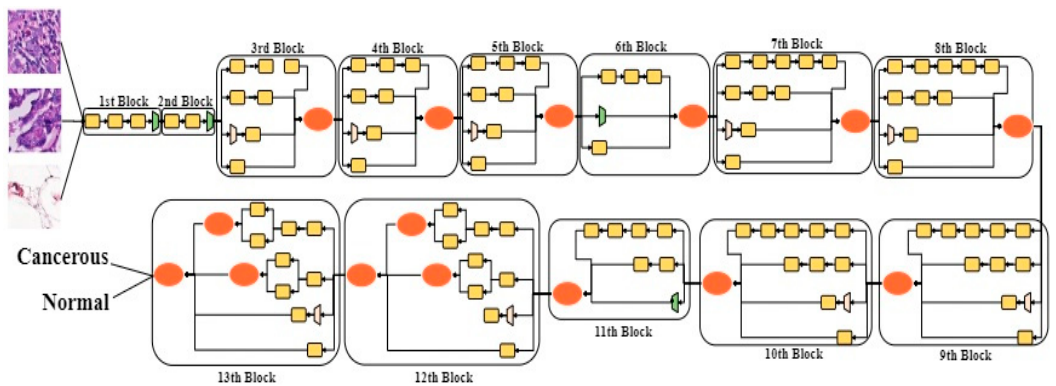
Figure 7. The Inception V3 architecture.